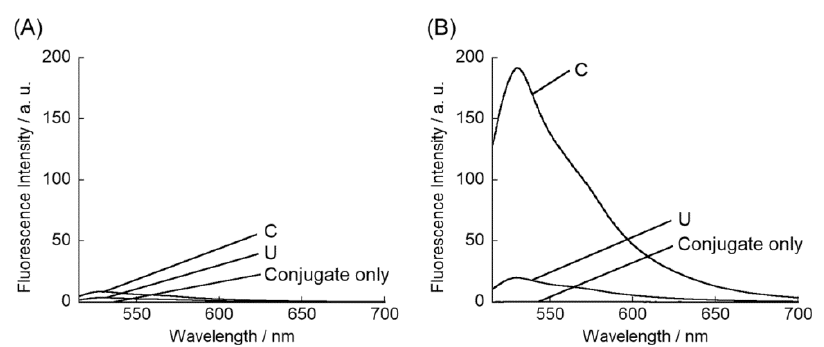
Figure 4. Fluorescence response of ClNaph – TO conjugate (500 nM) for target C or U in AP site- containing duplexes (500 nM): ( A ), AP – RNA duplex and ( B ) AP – DNA/RNA hybrid. Other